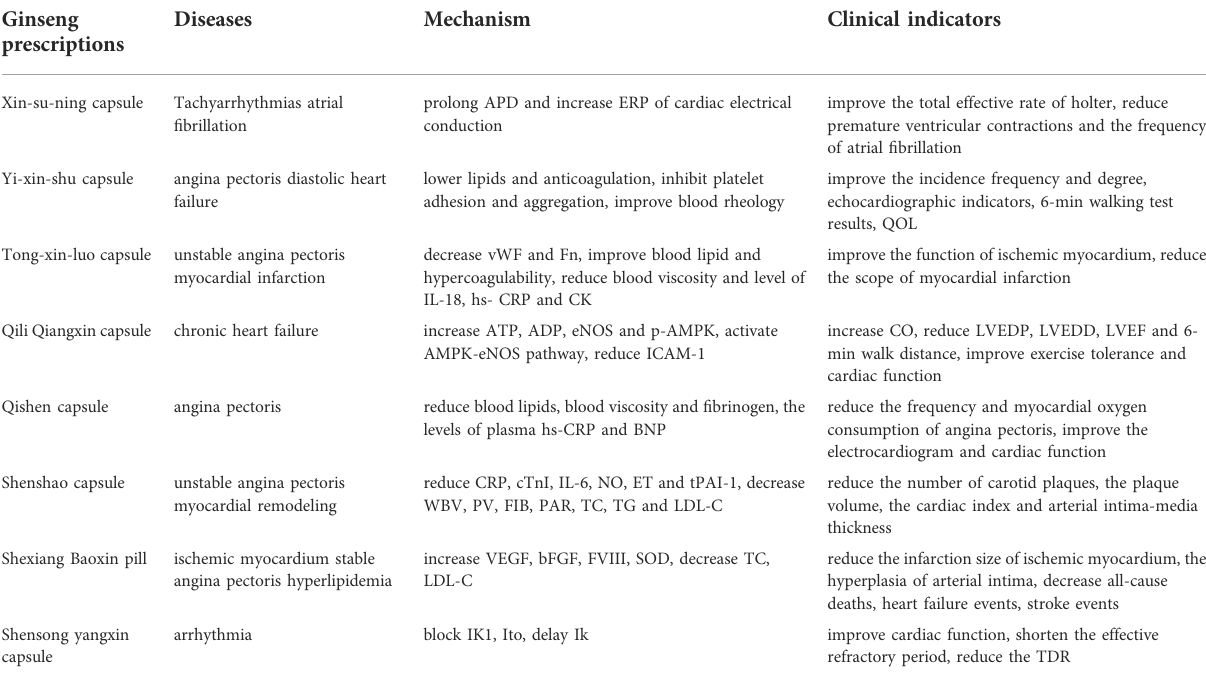
TABLE 2 Mechanism and Clinical Indicators of Ginseng Prescriptions in treating Cardiovascular Diseases. Ginseng